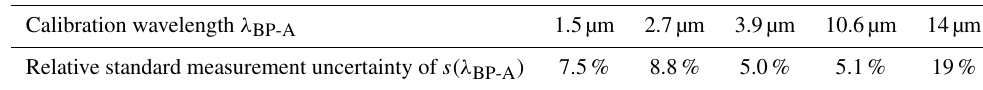
Table 2. Reached relative standard measurement uncertainties for the wavelengths which have been realized for detector calibrations at the blackbody radiator LABB by using characterized bandpass filters.